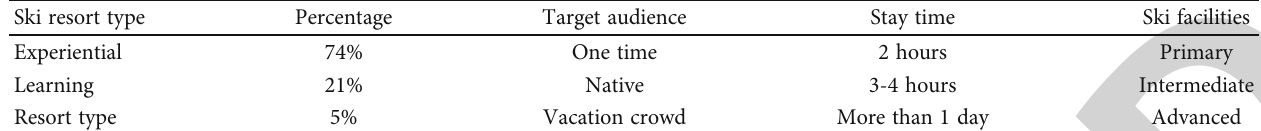
Table 2: Types of ski resorts.